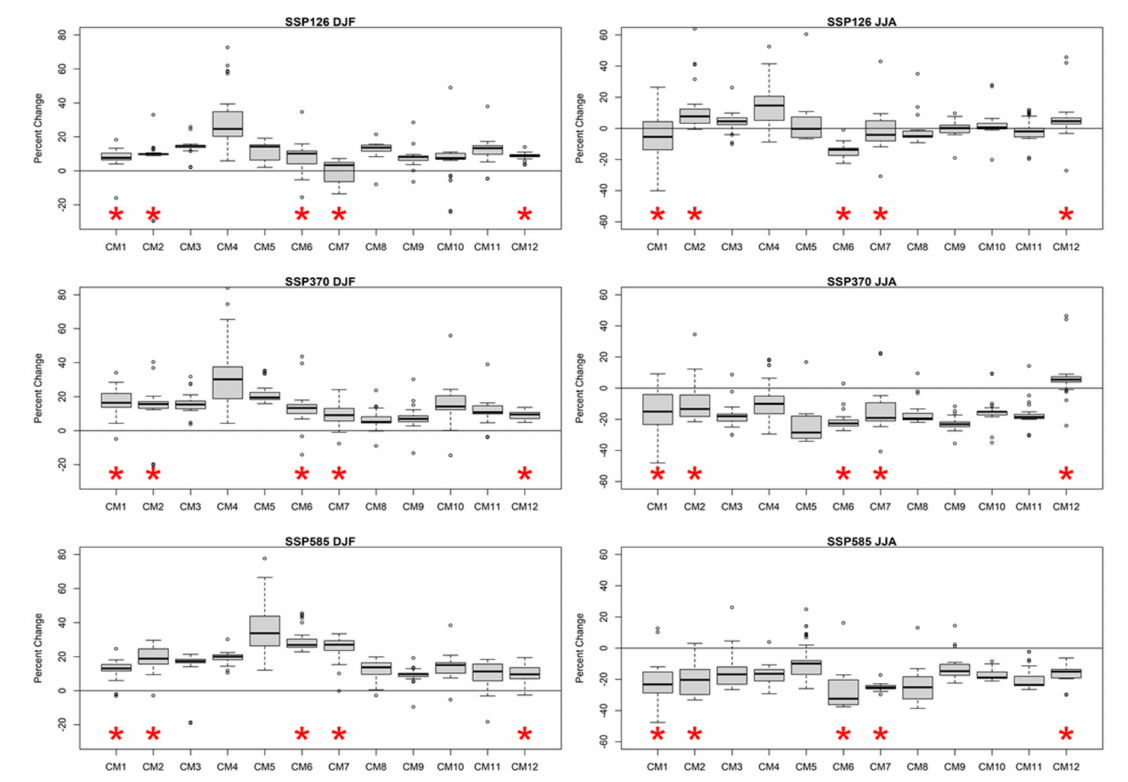
Figure 10. Simulated changes (percent) for winter ( left ) and summer ( right ) precipitation in each catchment for the 2080s derived from each of the 12 climate models employed (see Table 1). Results are presented for SSP126 ( top ), SSP370 ( middle ), and SSP585 ( bottom ). High-sensitivity climate models are denoted by an